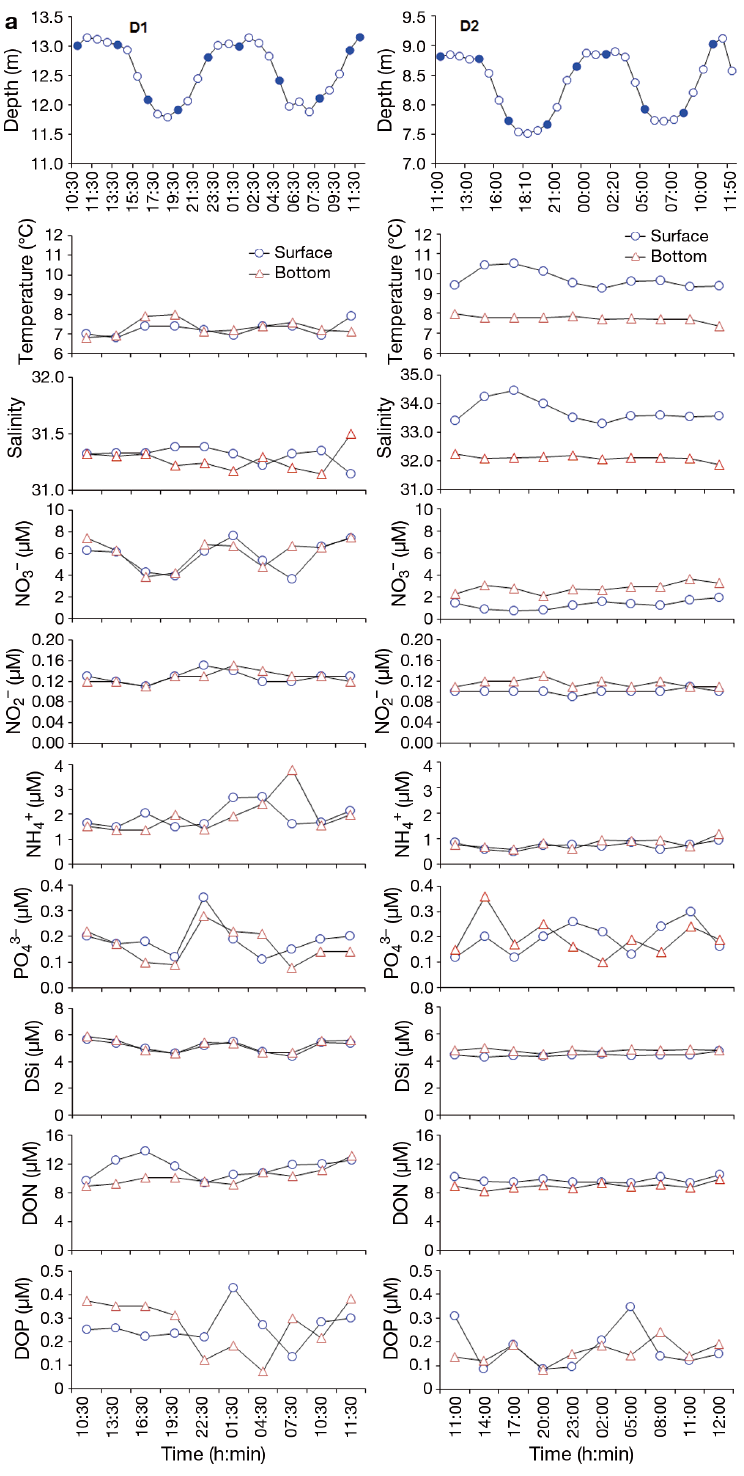
Fig. 7. Concentrations of nutrients (µM) at: (a) the anchor station in April 2013; (b; next page) the anchor station in October 2013. The water depth (m) in April 2013 and tide heights (cm) in October 2013 are provided, and the filled circles represent the nutrient sampling times. DSi: dissolved silicate, DON (DOP): dissolved organic nitrogen